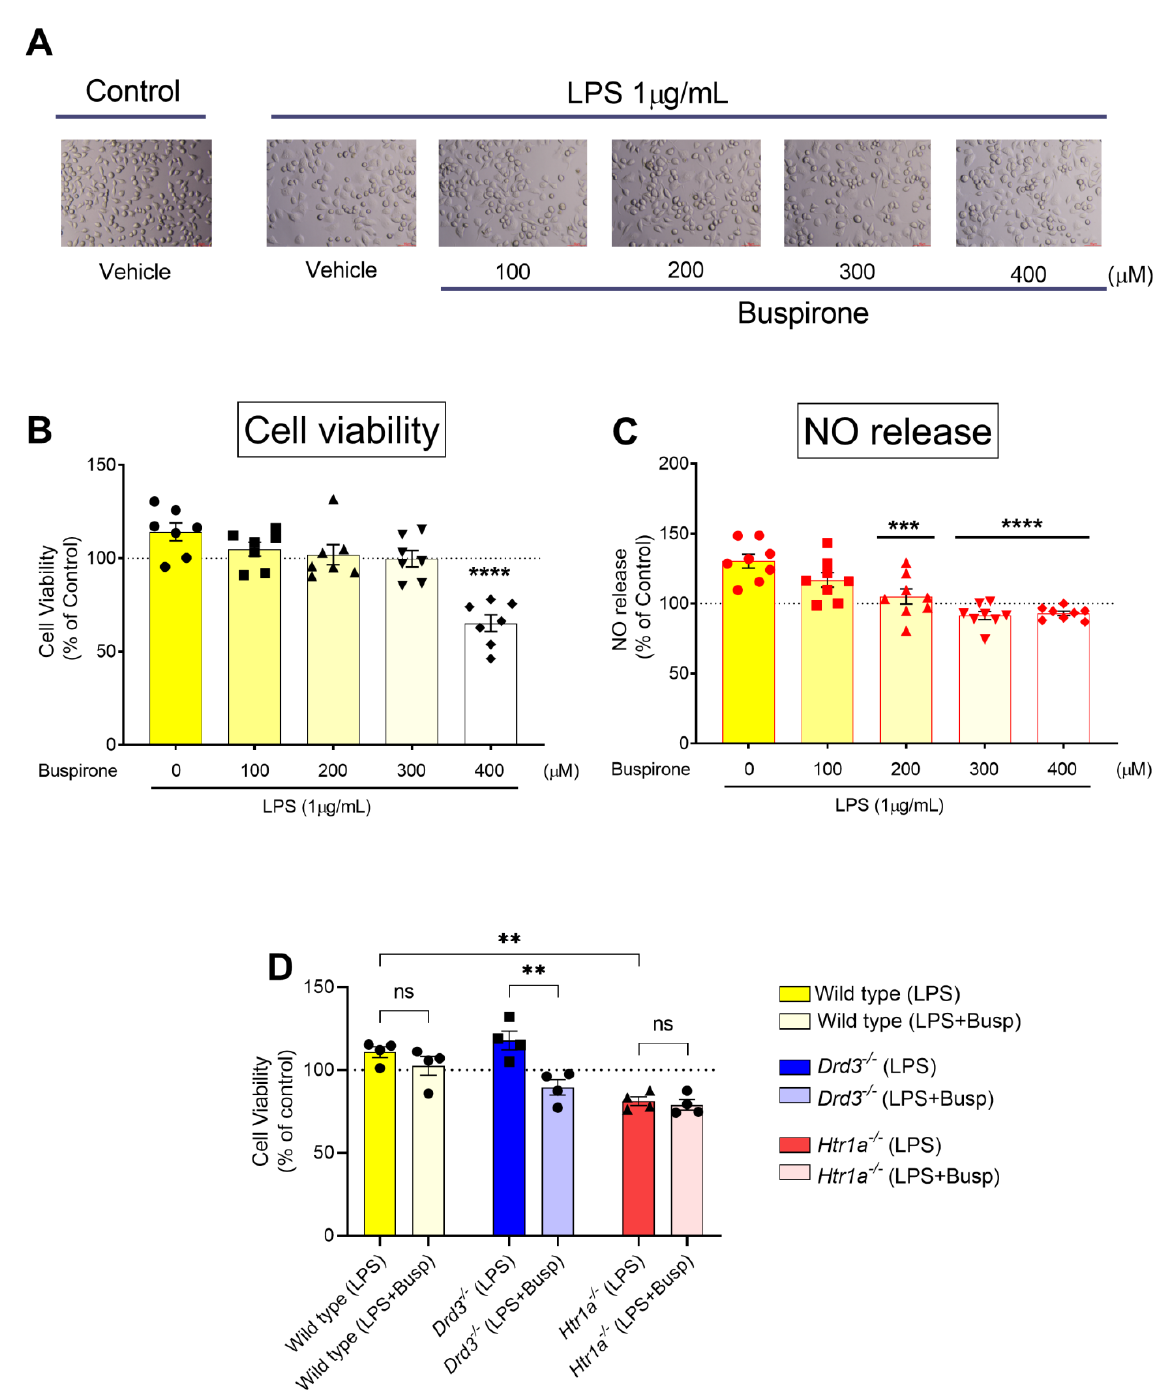
Figure 2. Effects of buspirone on cell viability in wild type, Drd3 − / − and Htr1a − / − BV-2 microglial cells after co-treatment LPS and buspirone. Cells were either treated with LPS (1 µ g/mL), alone or in combination with increasing concentrations of buspirone (100, 200, 300 and 400 µ M, respectively) for 24 h and representative photomicrographs (using embossing filter settings) were taken ( A ). BV-2 cells treated as in A were tested for changes in cell viability ( B ) or nitric oxide release ( C ). Wild-type, Drd3 − / − and Htr1a − / − BV-2 cells were treated with LPS and 300 µ M buspirone for 24 h before cell viability was assessed ( D ). Ns = not significant. Data reported is the mean ± SEM from at least two independent experiments. ** p < 0.01, *** p < 0.001, **** p < 0.0001 as determined by unpaired t -test ( A – C ) or two-way ANOVA followed by Tukey post-hoc test ( D ) Scale bar = 60 µ m. WT: wild type, Drd3 : murine dopamine D3 receptor gene, Htr1a : murine 5-hydroxytryptamine-1a receptor gene, LPS: